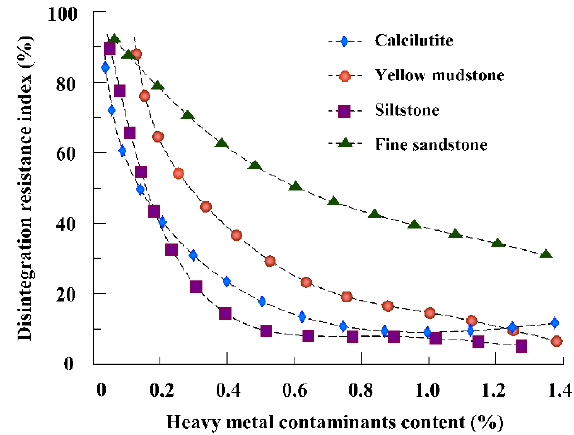
Fig. 3. The relationship between disintegration resistance and heavy metal content